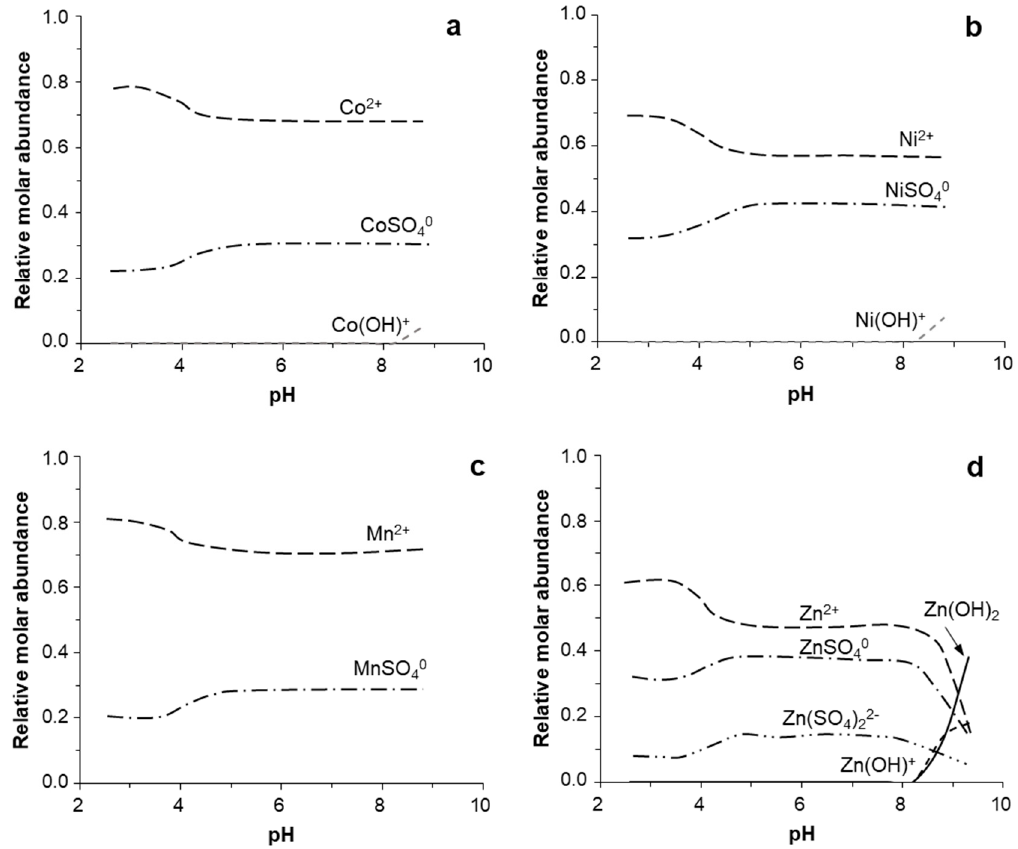
Figure 8. Relative molar abundance of major ionic species of different metals in the pH range 2.0–10.0: ( a ) Co, ( b ) Ni, ( c ) Mn, and ( d ) Zn. Calculations conducted with PHREEQC using the MinteqA2.v4 thermodynamic database for conditions of [Co(II)] = [Ni(II)] = [Mn(II)] = [Zn(II)] = 10 − 5